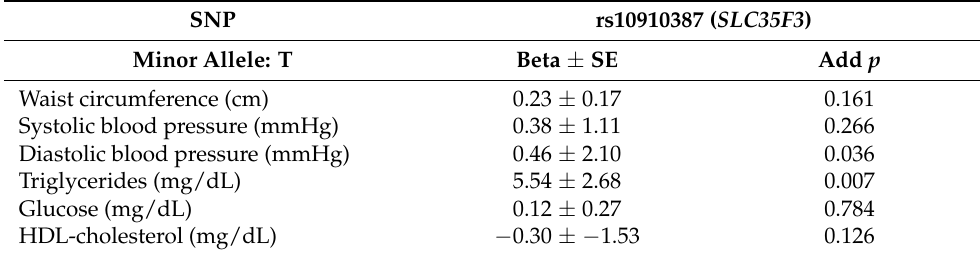
Table 3. Association of SLC35F3 rs10910387 with metabolic syndrome